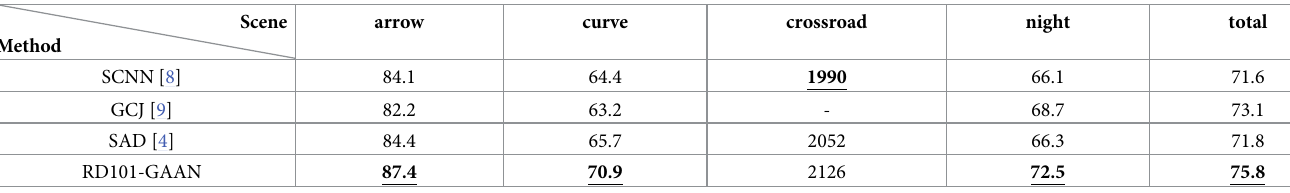
Table 3. F1-Measure of several methods on CULane